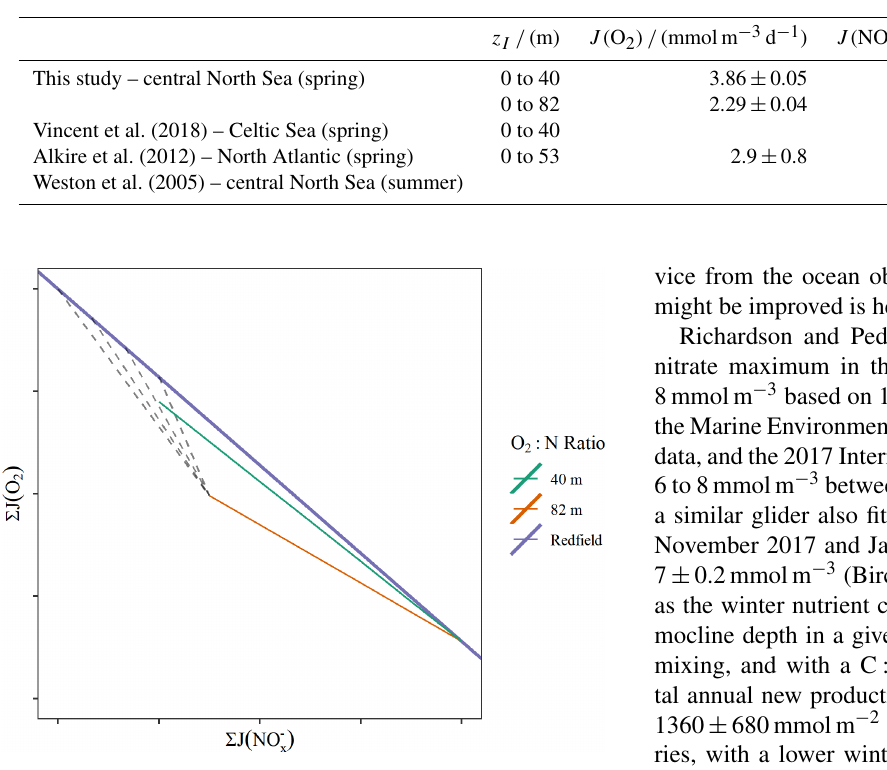
Table 2. Voluminal comparison with recent studies.